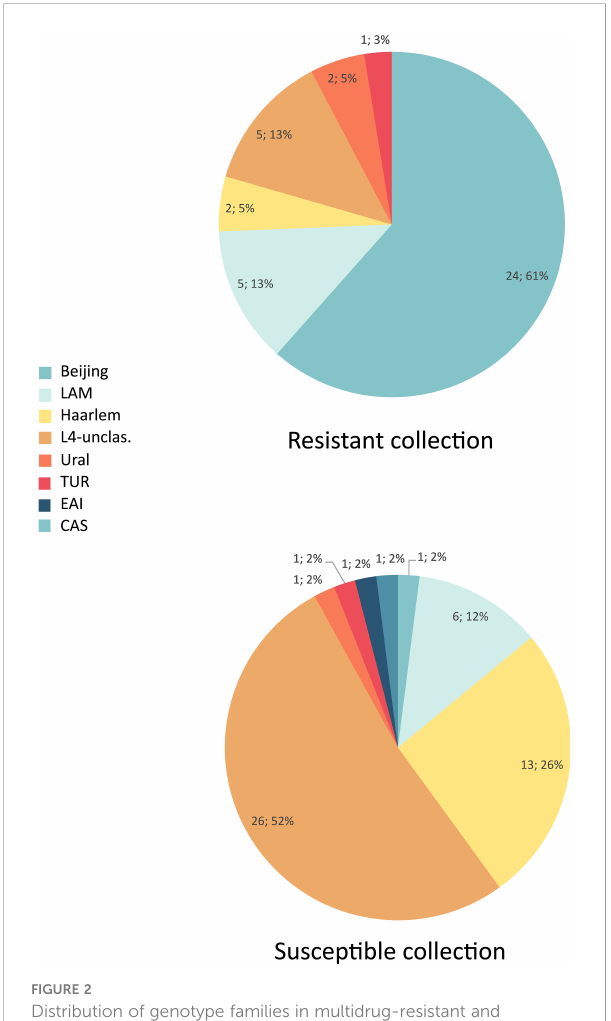
FIGURE 2 Distribution of genotype families in multidrug-resistant and susceptible